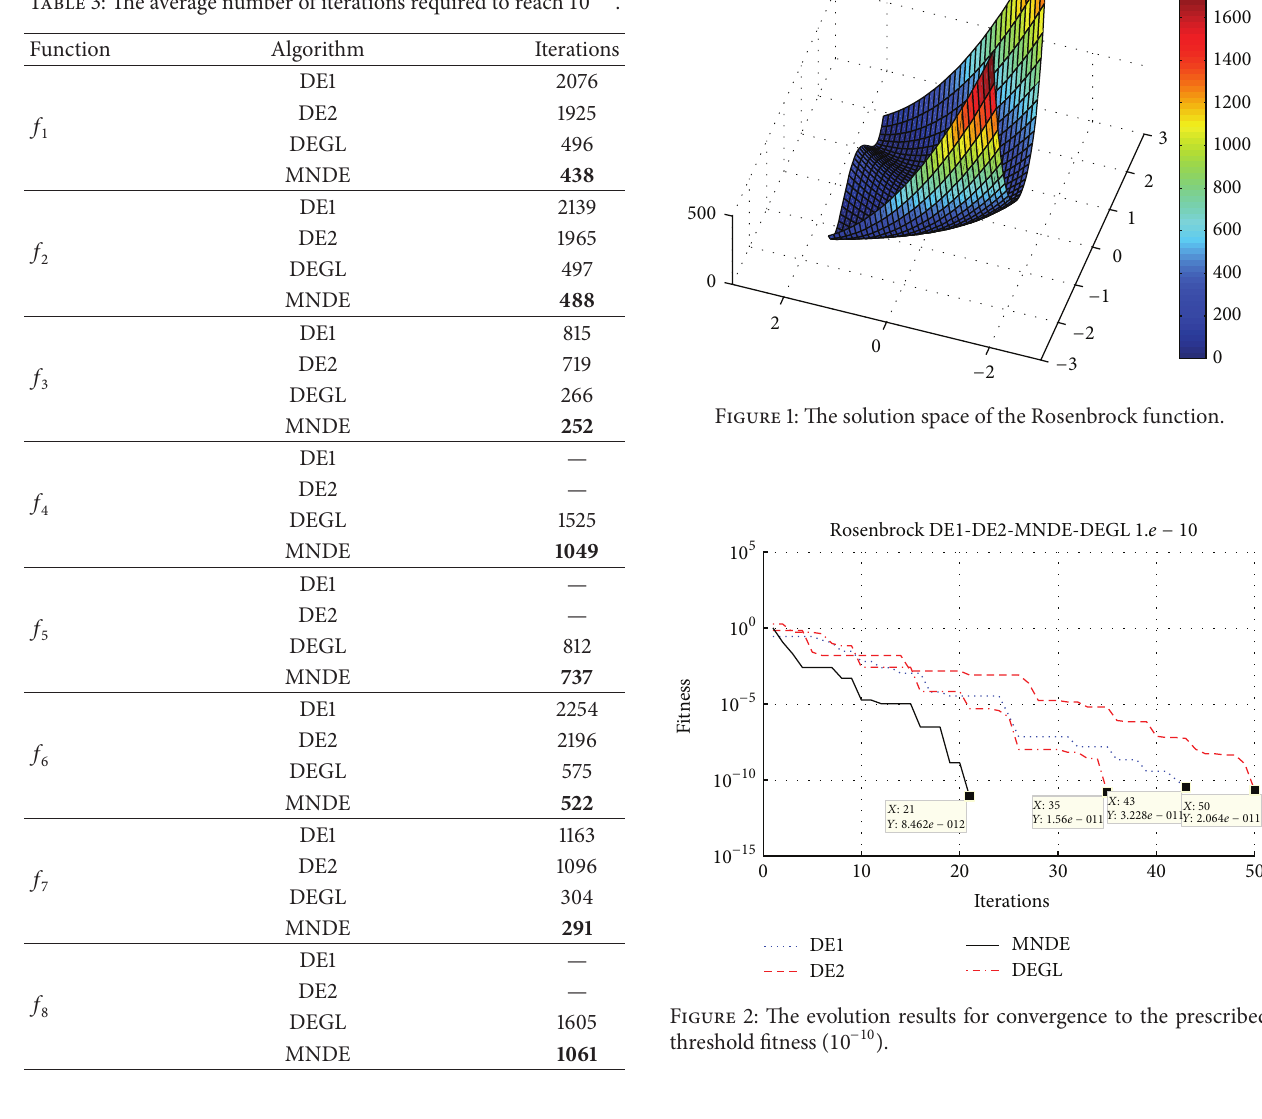
Table 3: The average number of iterations required to reach 10 −10 .